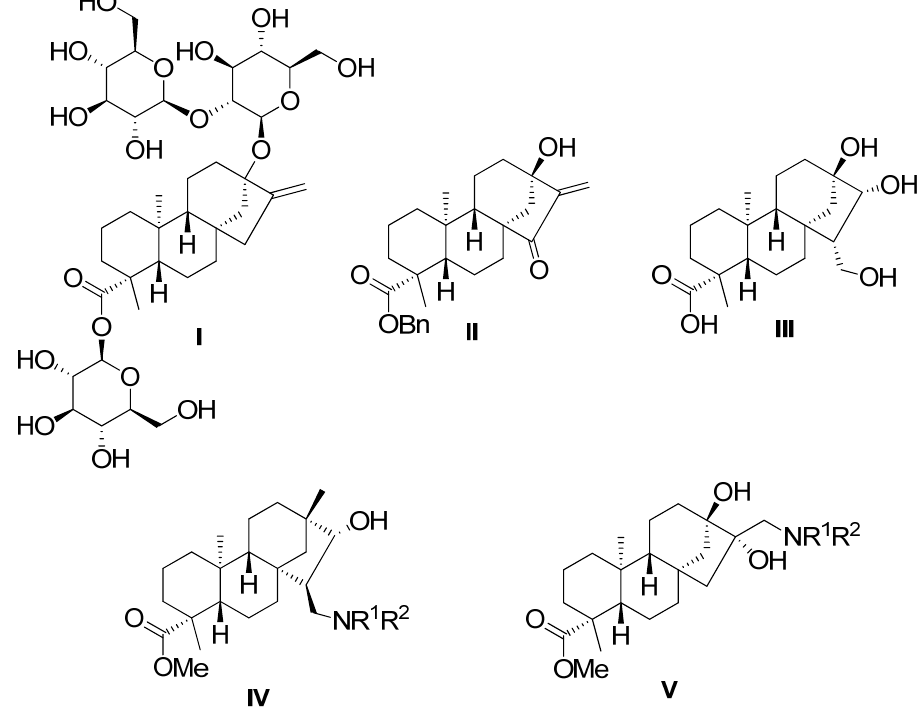
Figure 1. Bioactive compounds with steviol- and isosteviol-type skeleton derived from stevioside.